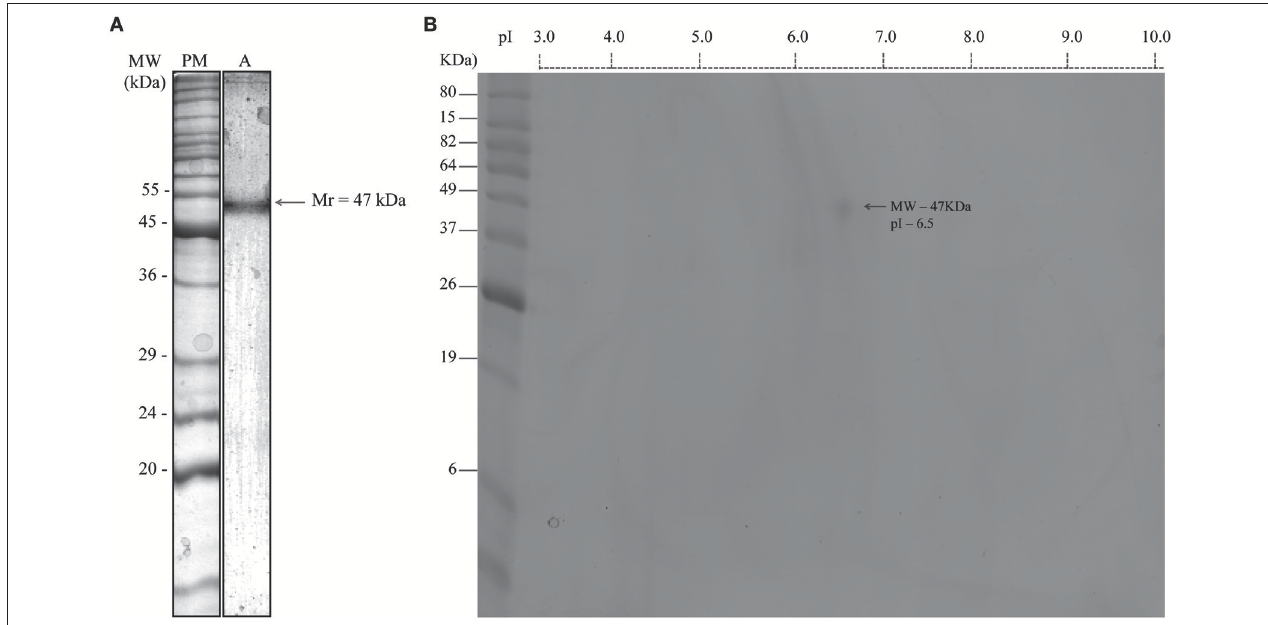
FIGURE 1 | Identification of maturase k in acetonic fraction from Bidens pilosa stained by Coomassie brilliant blue G-250 ® , resolved by 12% SDS-PAGE. (A) One-dimensional gel electrophoresis (1-DE). (A) Apparent molecular mass (Mr) of the B. pilosa acetonic fraction is shown on the right as determined by Kodak 1D image analysis. Representative gel image from four independent experiments. (B) Two-dimensional gel electrophoresis (2-DE). Isoelectric focusing (IEF) was performed on 7cm immobilized pH gradient strips (ReadyStrip TM IPG Strip pH 3–10). The protein spot was determined by ImageMasterTM 2D Platinum 7.0 software. The spot is identified by arrow. Molecular weight markers (MW) are indicated on the left in kiloDalton (kDa) and the range of isoelectric point (pI) is indicated above the panel. Representative gel image from two matched independent experiments.